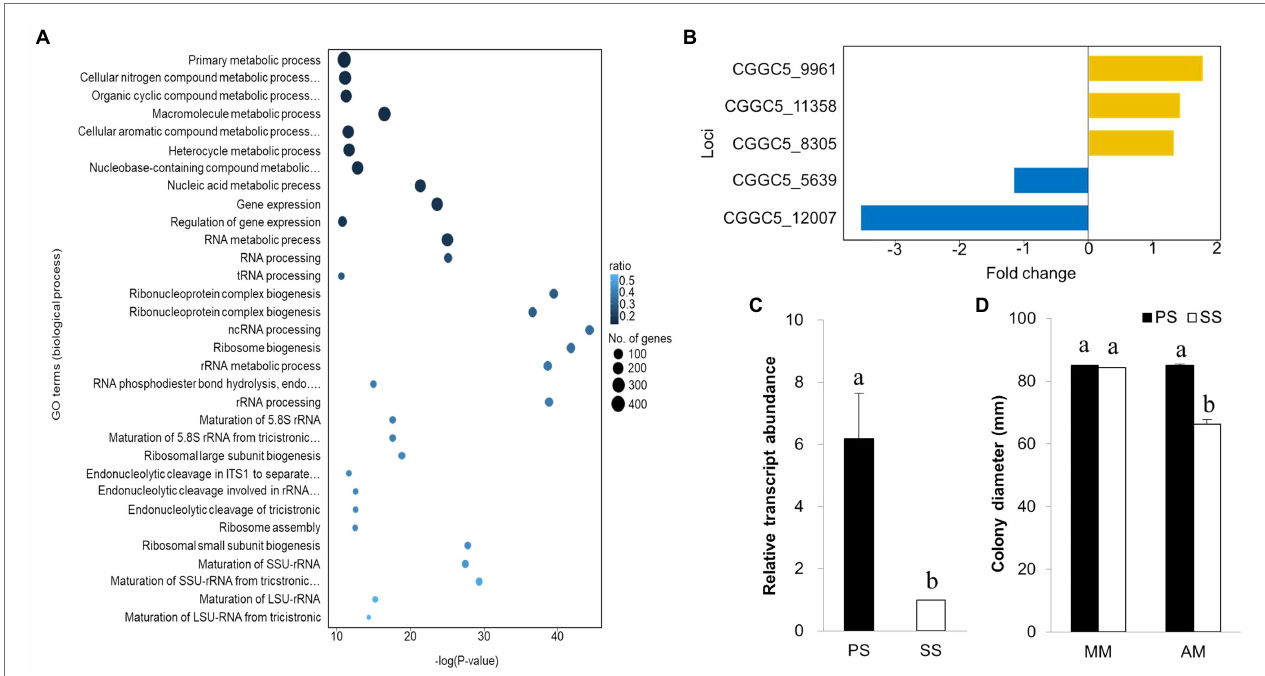
FIGURE 7 | Gene ontology, expression of virulence gene, and expression of isocitrate lyase gene. (A) Gene ontology analysis for downregulated genes in both SS and PS in biological process based on functional categories. (B) Expression of the pathogenicity gene using RNA-seq analysis and comparison with other known virulence genes from NCBI. Isocitrate lyase gene expression in the PS pathogen at a greater level (upregulation) in comparison with SS strains. (C) The gene expression was greater in PS than in SS strain of C. gloeosporioides . (D) Mycelial growth of PS and SS of C. gloeosporioides in two different media [minimal medium (MM) and acetate medium (AM)]. SS was unable to utilize acetate as the sole carbon source for its growth. Bars with the same letters do not statistically differ from each other, according to the least significant difference (LSD) at p <